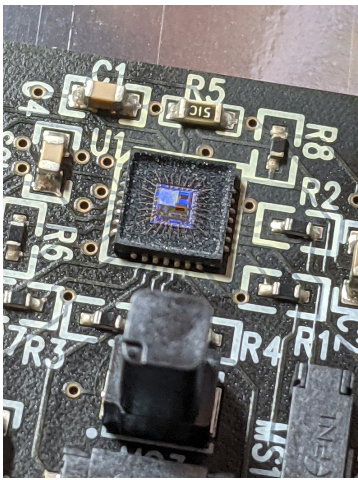
Figure 1. PNI RM3100 ASIC device close-up after decapsulation by SAGE Analytical